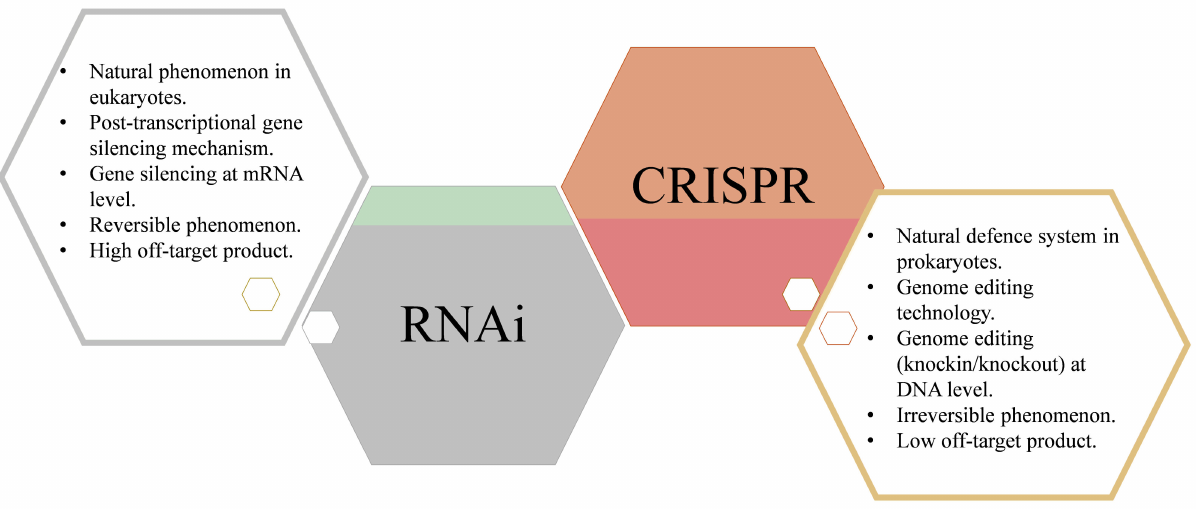
Figure 4. RNA interference vs. the CRISPR/Cas9